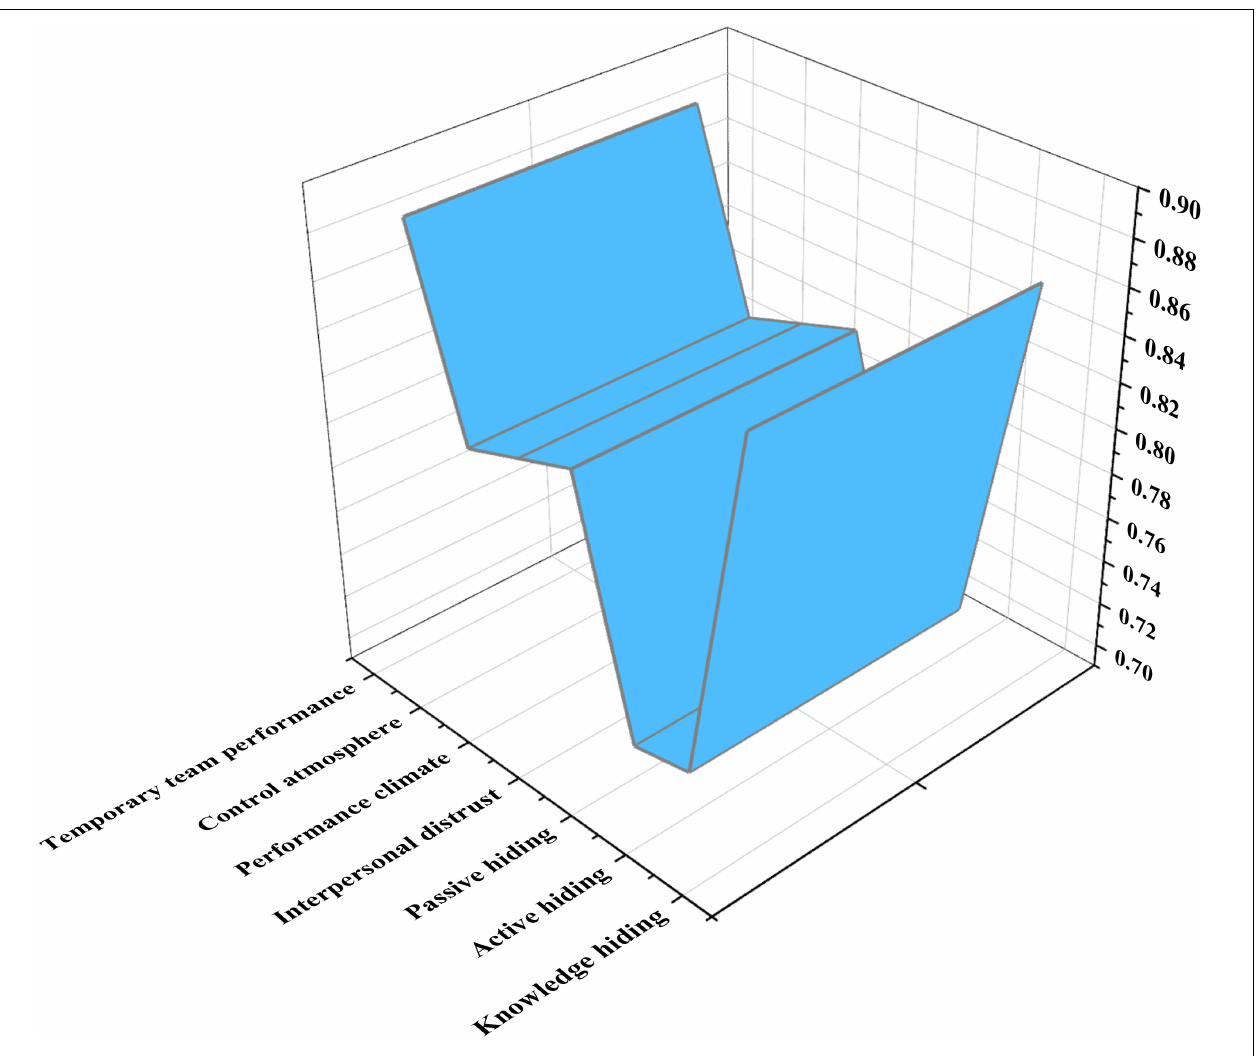
FIGURE 6 | Variable’s r wg coefficient of each